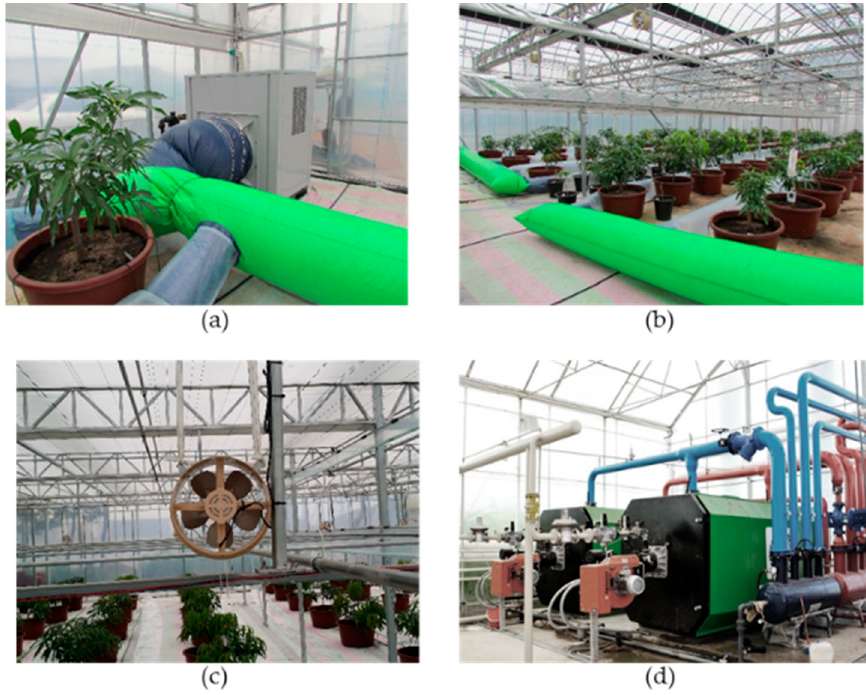
Figure 3. Equipment for heat distribution inside the greenhouse ( a ) main air duct, ( b ) sub air duct near crop surface, ( c ) circulation fan and ( d ) heat pump unit.